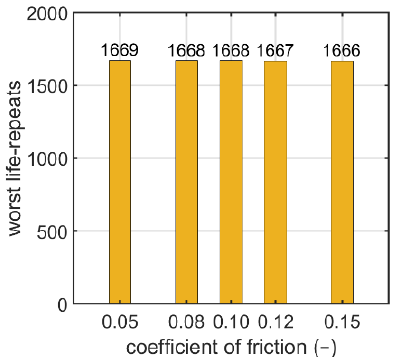
Figure 19. Number of logarithmic life repeats for parametrizing the coefficient of friction of the nutless bolt.